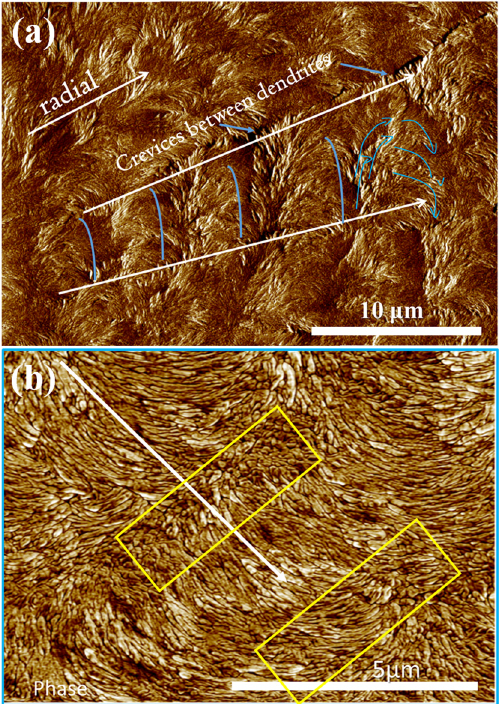
Figure 5. ( a ) Integrated AFM phase images, ( b ) integrated phase images for PPDO/PVPh = 75/25, at T c = 78 °C, displaying individual rings along the lengthwise direction of the arms of the dendritic- rings, and interfacial crevices between dendrites.